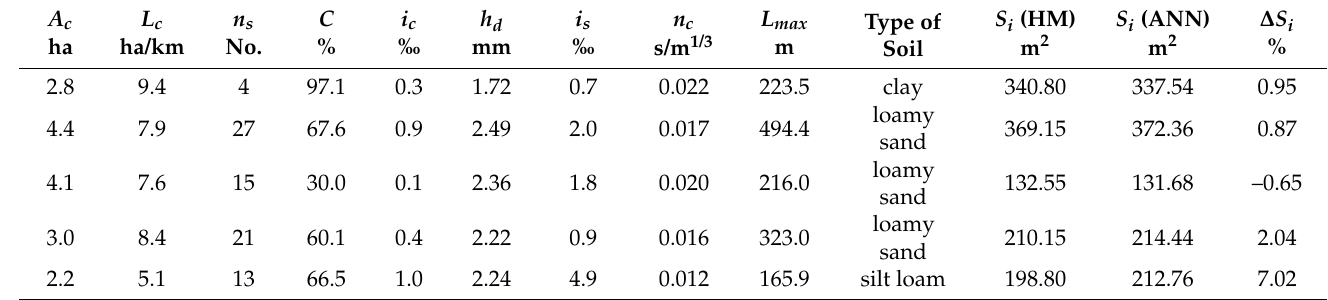
Table A5. Comparison of the required areas of the completely drained infiltration tank ( S i ) generated for a random combination of input parameters from the MLP 12-5-1 (ANN) artificial neural network (ANN) and those obtained from the hydrodynamic simulations (HM) (designations as in Figure